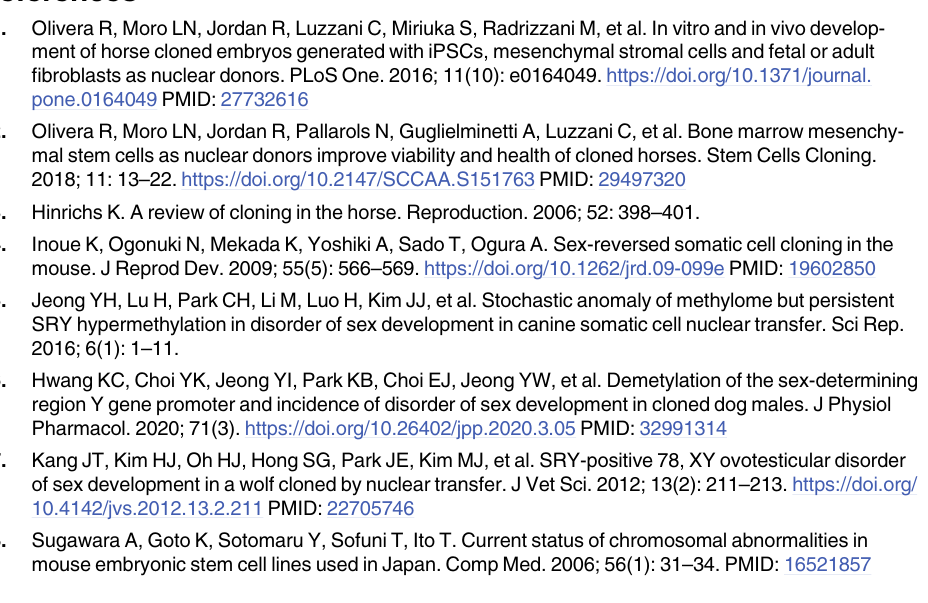
S1 Table. Primer sequences for the genotype identification of the cloned foals. S2 Table. Primer sequences of the sex chromosomes molecular